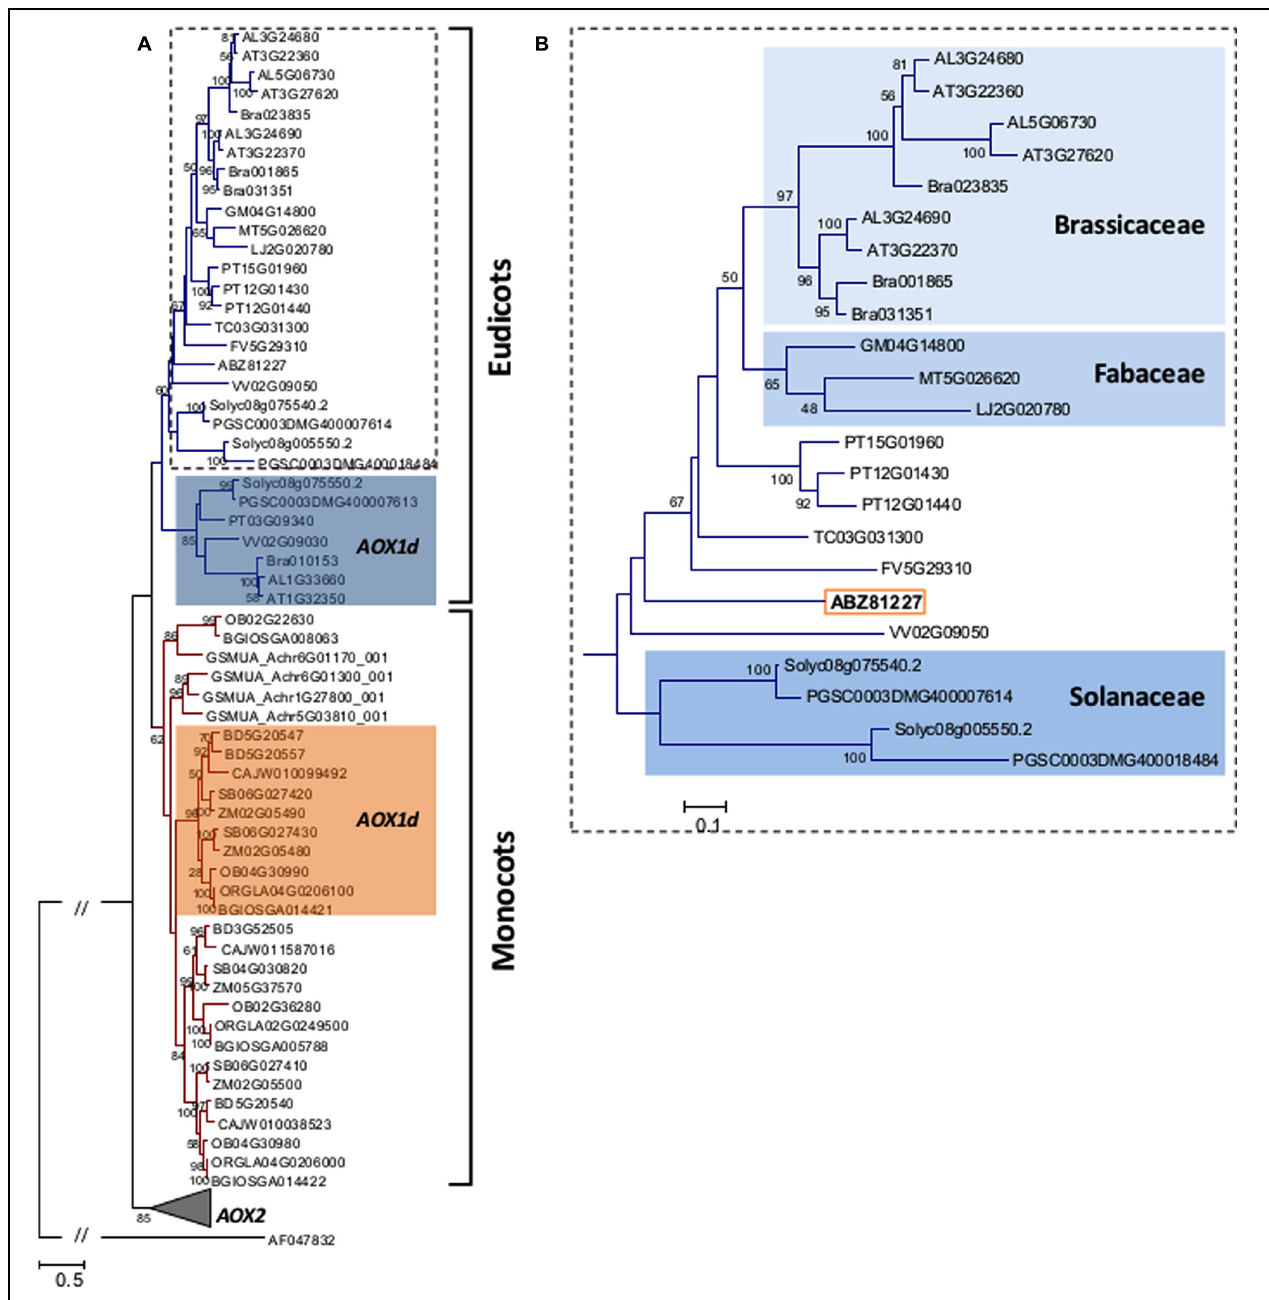
FIGURE 8 | (A) Maximum likelihood (ML) tree showing the relationships among translated amino acid sequences of previously reported AOX1 proteins from plants, including the DcAOX1 sequence (ABZ81227.2) of D. carota L. cv. Rotin. Phylogeny reconstruction was done following the parameters described in the Section “Material and Methods”. Data retrieved from public web-based databases, freely available (Plaza: http://bioinformatics.psb.ugent.be/plaza/; e!EnsemblPlants: http:// plants.ensembl.org/Multi/Search/New?db = core; and NCBI: http://www.ncbi.nlm.nih.gov/). AOX sequences were annotated by Cardoso et al. (2015) and AOX1 sequences are identified in Supplemental Table S1. (B) AOX eudicot clade, without AOX1d representatives, showing the position of DcAOX1 sequence